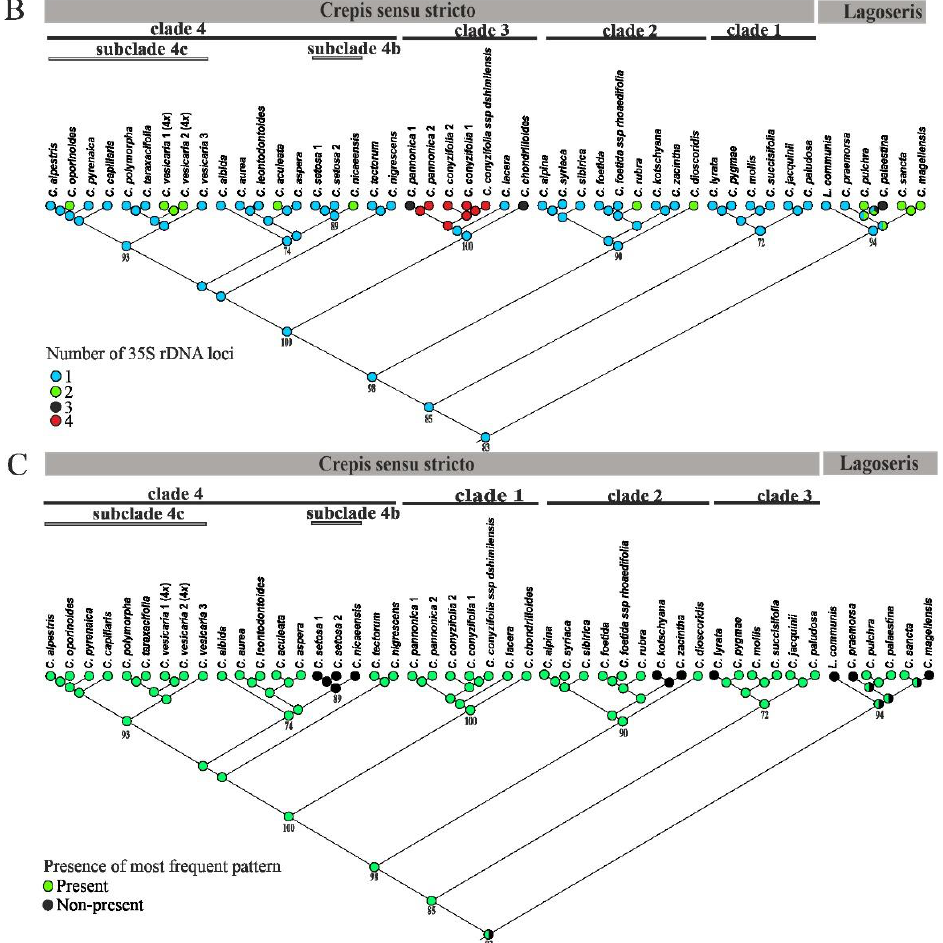
Figure 7. Ancestral character state reconstruction of the rDNA locus number and localisation for Crepis s.l. The numbers and localisation of the rDNA loci were mapped onto the ML tree of the nrITS sequences using maximum likelihood methods. ( A ) Number of 5S rDNA loci. ( B ) Number of 35S rDNA. ( C ) Presence/absence of the chromosome carrying both 35S and 5S rDNA loci within the same